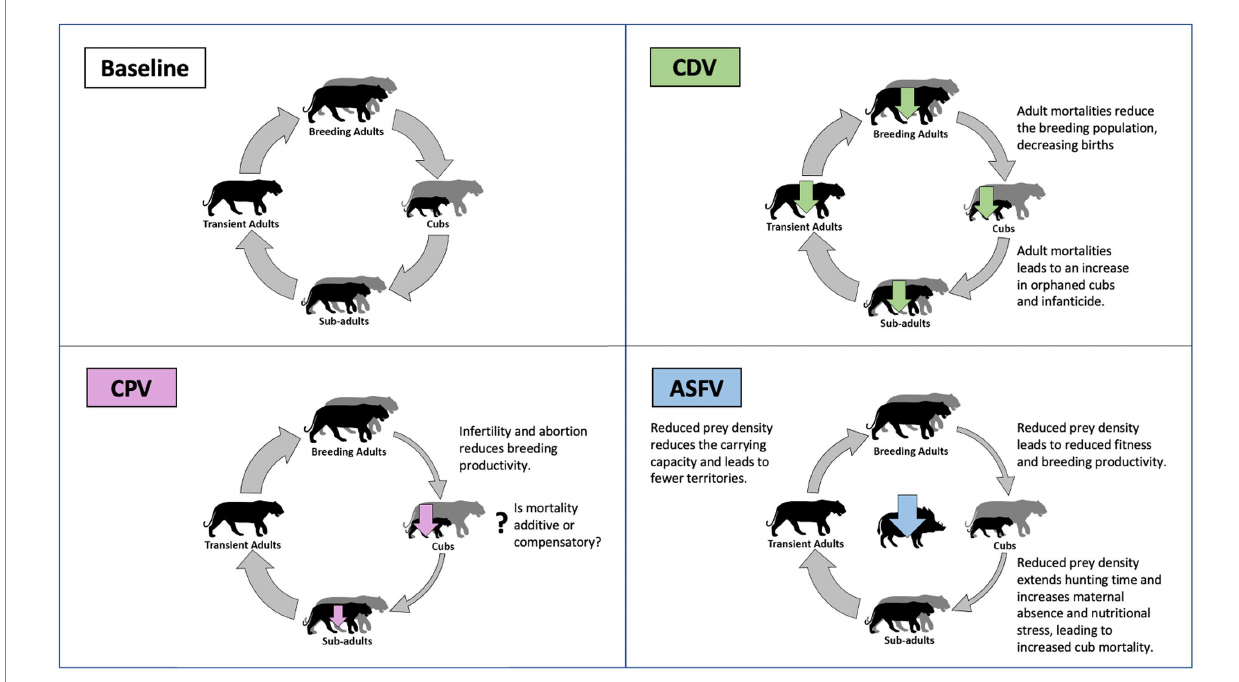
FIGURE 1 Schematic illustration of ways in which disease can threaten tiger populations compared to a baseline population where disease is absent. Populations consist of breeding adults (with territories), cubs (0–1 year), subadults (1 year–independence) and non-breeding transient adults (without territories). Example pathogens are used to illustrate three ways in which disease can impact tiger populations and include canine distemper virus (CDV–Reduces survival of breeding tigers), canine protoparvovirus 1 (CPV–Reduces productivity of breeding tigers), and African swine fever virus (ASFV–Reduces the carrying capacity of tiger habitat). Disease-related mortality is represented using vertical arrows (over tiger life stages, or wild boar prey) and is scaled according to relative severity. Transition between tiger life stages is represented by circular arrows, which are colored to represent transitions that are constrained by disease and scaled to indicate